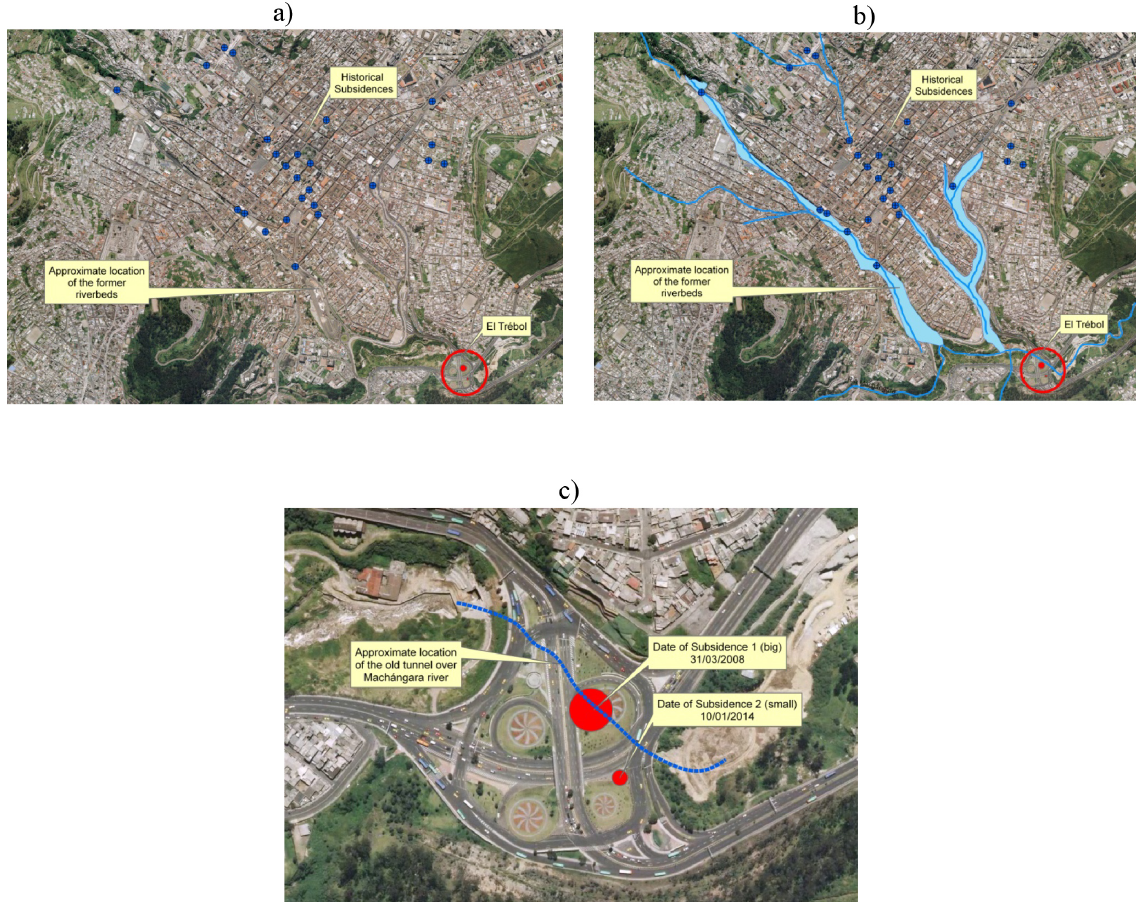
Figure 2. (a–c) Historical subsidences at Machángara river, El Trébol sector.